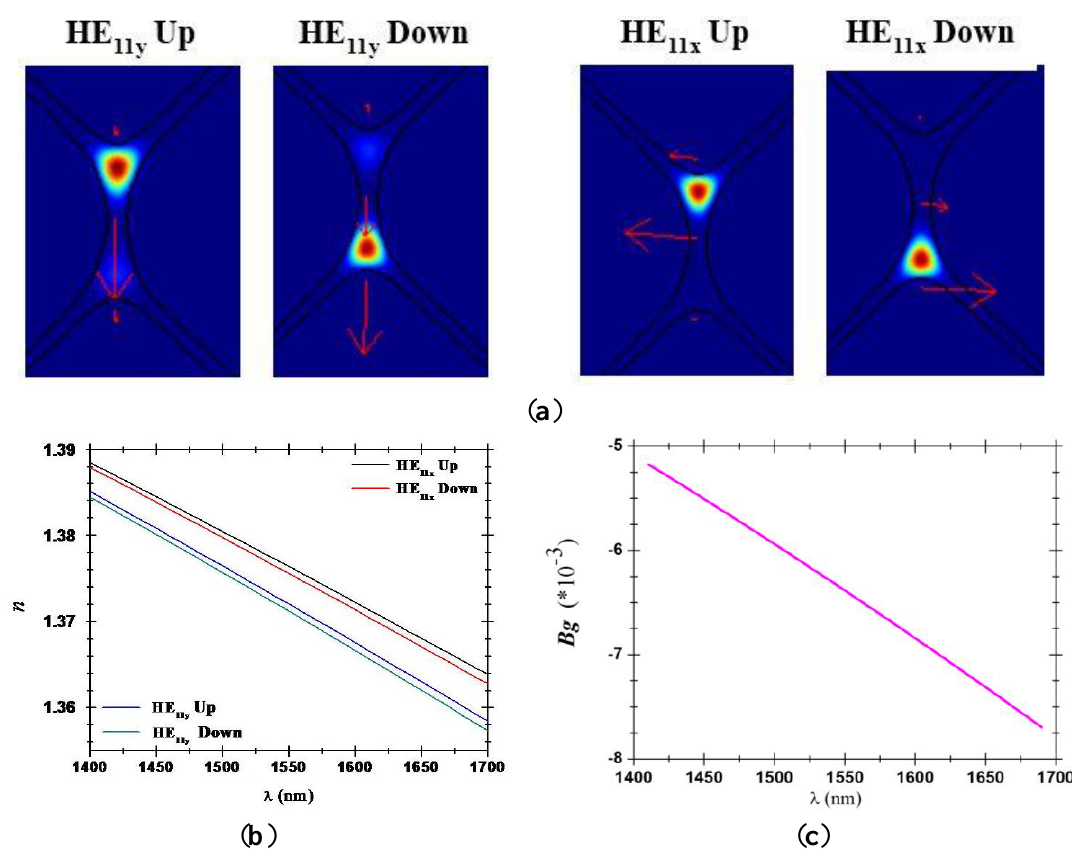
Figure 2. ( a ) Field distribution of HE 11 x and HE 11 y up and down modal components of LP 01 ; ( b ) Effective refractive indices versus wavelength; ( c ) Group birefringence versus the